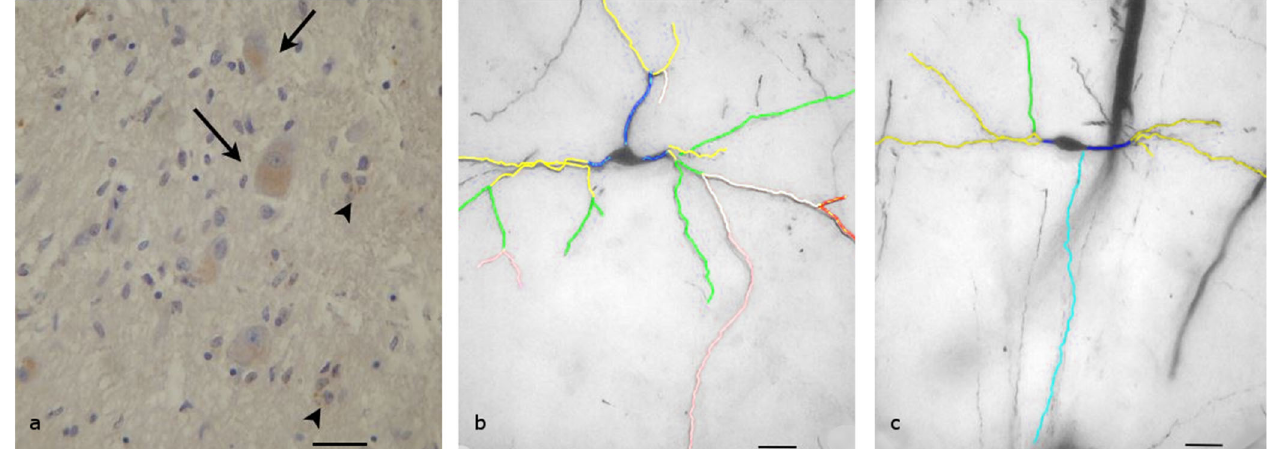
Figure 6. Paraventricular Nucleus of the human Hypothalamus: ( a ) Immunohistochemical staining, specific for OX1R. The big neurons, which are similar to SI neurons (black arrows), are more immunopositive for OX1R than the small neurons of the paraventricular nucleus (arrow heads) (Scale bar, 30 μ m); ( b ) A large, Golgi-stained neuron mapped by the ImageJ program. Primary (dark blue), secondary (yellow), tertiary (green), quaternary (pink) and even quinary (red) dendrites can be found. Light blue depicts the axon of the neuron. The big neurons are similar to SI neurons of the supraoptic nucleus and can be found mainly in the magnocellular compartment (Scale bar, 30 μ m); ( c ) A small Golgi-stained neuron mapped by the ImageJ program. Primary (dark blue), secondary (yellow) and tertiary (green) dendrites can be found. Light blue depicts the axon of the neuron. There is a variety of small neurons, which have many differences in morphology (Scale bar, 20 μ m).